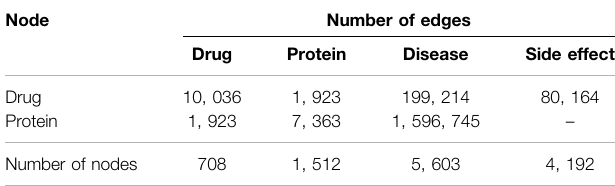
TABLE 2 | Number of nodes and edges of individual types in the constructed heterogeneous network on DTINet (Luo et al., 2017).